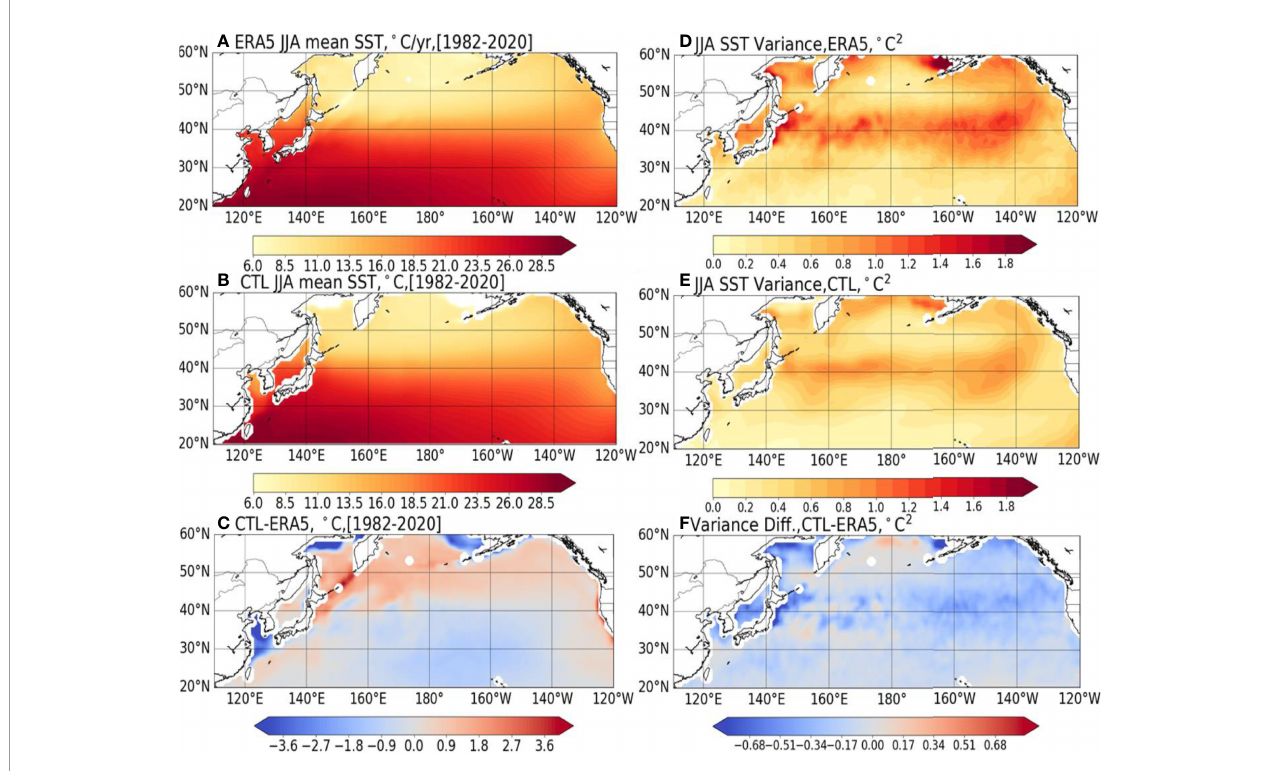
FIGURE 4 | (A) The mapofERA5 SSTclimatologyfrom 1982to2020for the Paci fi cregion(20°~60°N,120°E~120°W)insummer, (B) MOM5Exp_CTL, (C) Figure showingdifference ofSST climatology(Exp_CTLminusERA5). (D) VarianceofSSTcalculatedthroughERA5SSTanomaly, (E) MOM5Exp_CTL, (F)